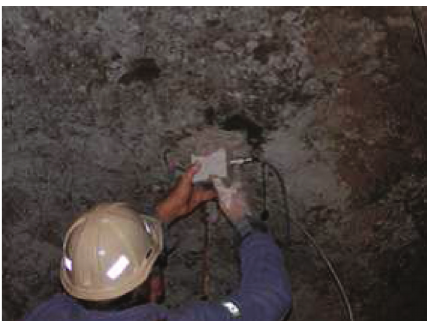
Figure 9: The accelerometer located on the mining corridor roof.